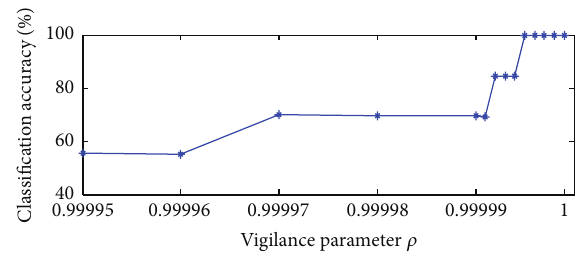
Figure6:Classificationaccuracywiththedifferentvigilanceparam- eters.